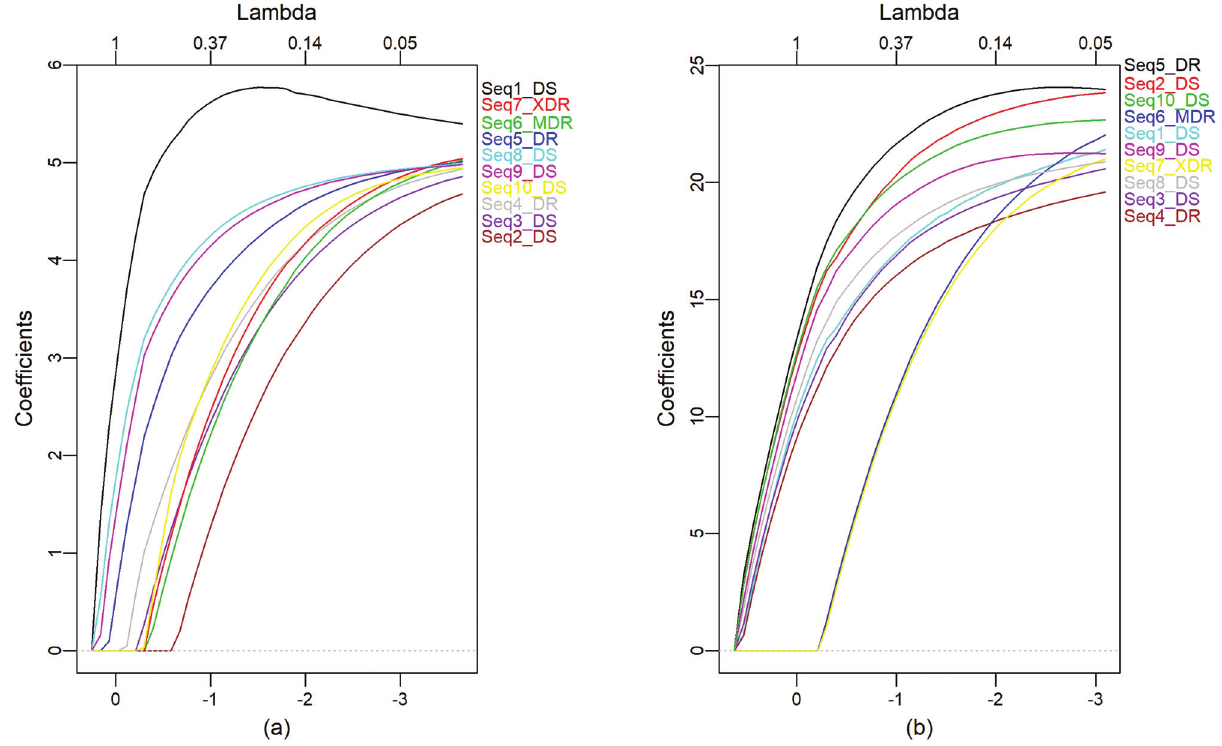
Figure 3 - Elastic net for: (a) signals of the GC-content sequences, (b) s5 coefficients.